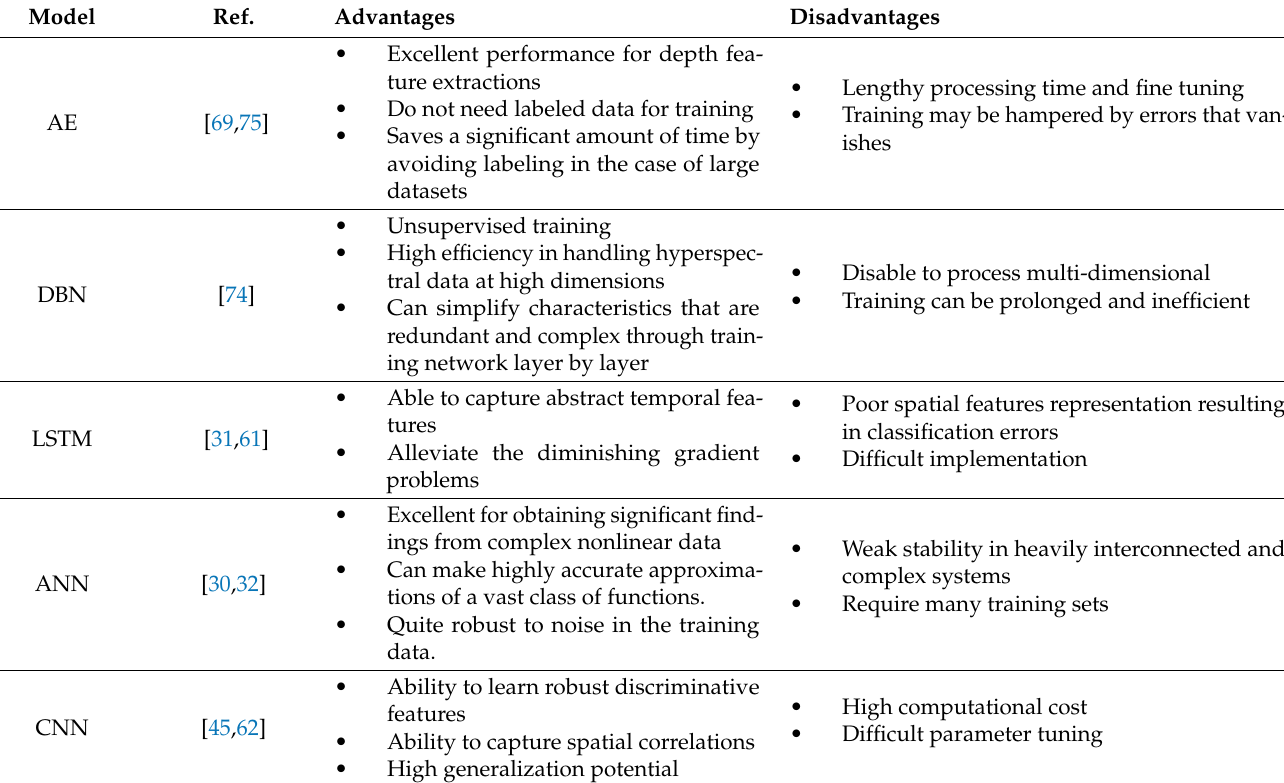
Table 5. Common DL architectures with their benefits and